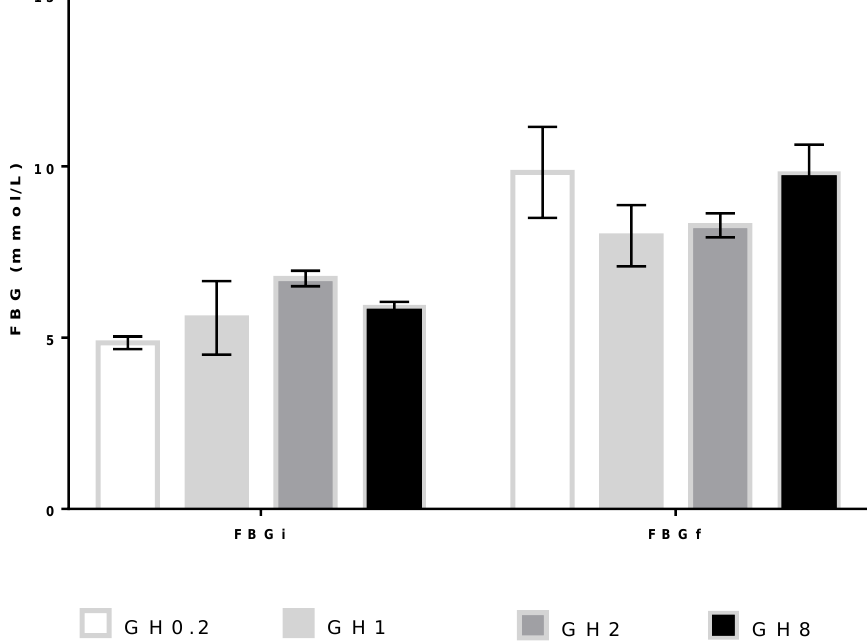
Figure 5. Fasting blood glucose (FBG) levels at day 0 before the administration of Gelam honey (GH; FBGi) and day 14 after the GH administration (FBGf). GH0.2 (0.2 g GH/kg bw/day); GH1 (1 g GH/kg